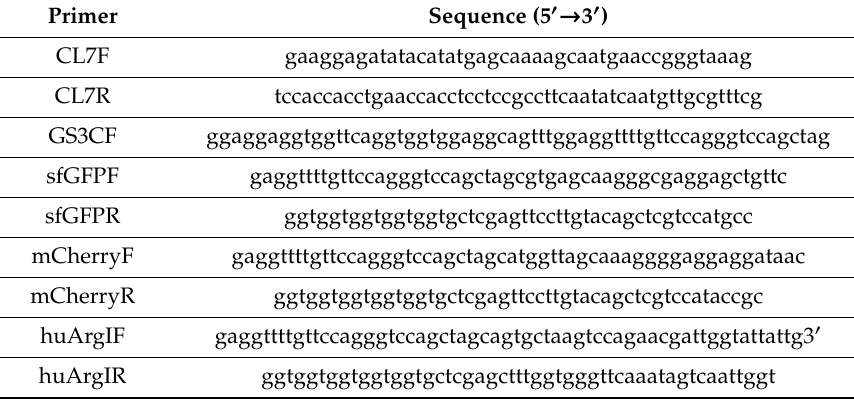
The primers used for the construction of plasmids including pET23a-CL7-sfGFP, pET23a-CL7-mCherry and pET23a-CL7-huArg I.